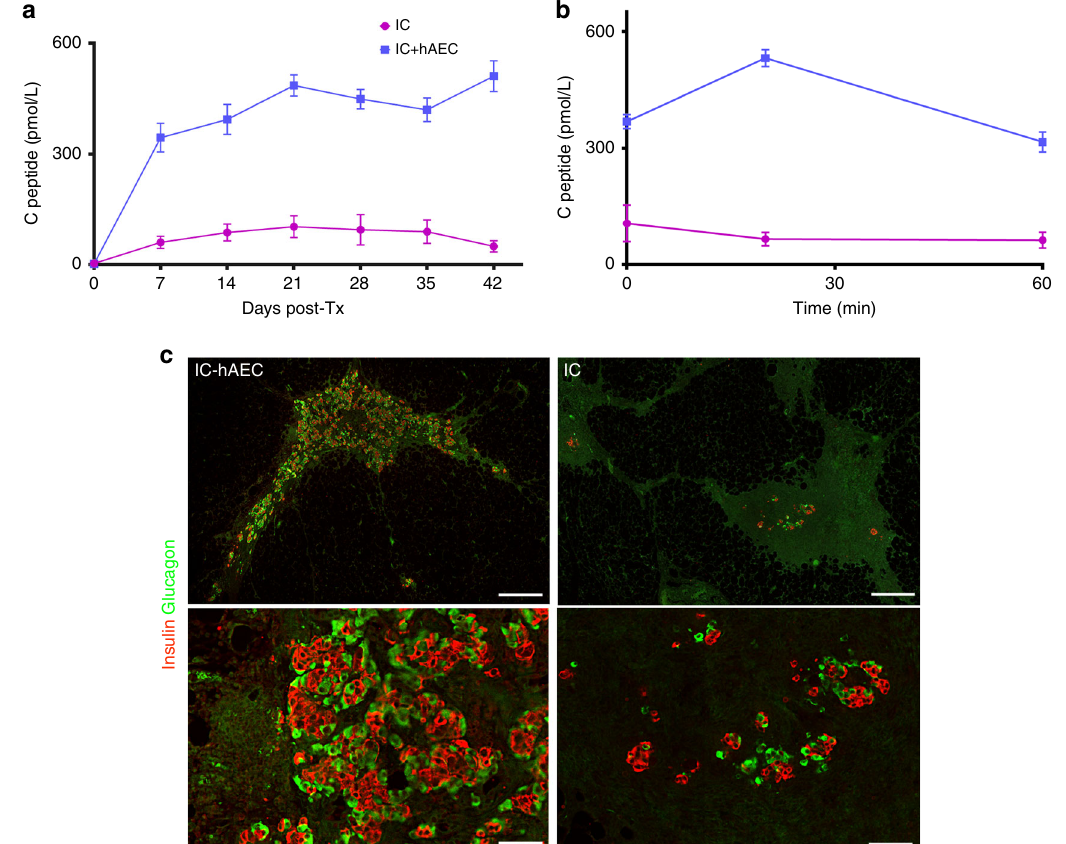
Fig. 8 Function of a human-derived organoids transplanted in the epididymal fat pad. a Human C-peptide measurements of mice transplanted with 300 islet organoids (IC-hAEC group, blue squares, n = 10), or with 300 islet-cell spheroids (IC group; magneta circles, n = 8) *** p < 0.0007, unpaired Student ’ s t test. b Human C-peptide levels after intraperitoneal glucose challenge 4 weeks after transplantation. Magneta circles: IC, blue squares: IC-hAEC. ** p < 0.008, unpaired Student ’ s t test, n = 5. c Representative images of the graft stained for insulin (red) and glucagon (green). Scale bar, upper panel 500 μ m,